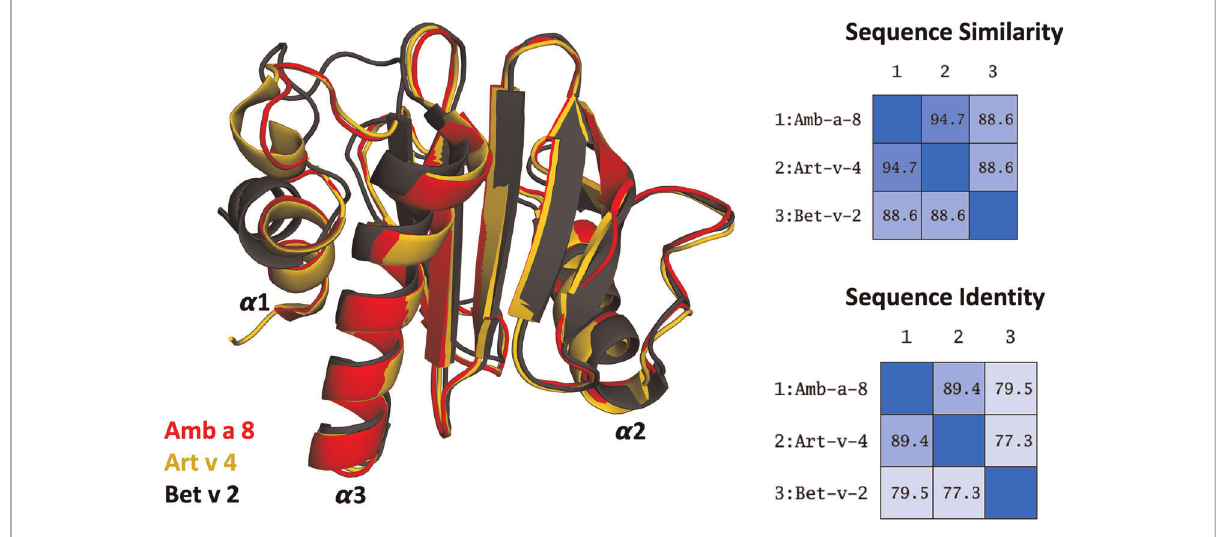
FIGURE 1 Overlay of the structures of the three simulated pro fi lin allergens. Sequence similarity and identity between the systems is shown on the